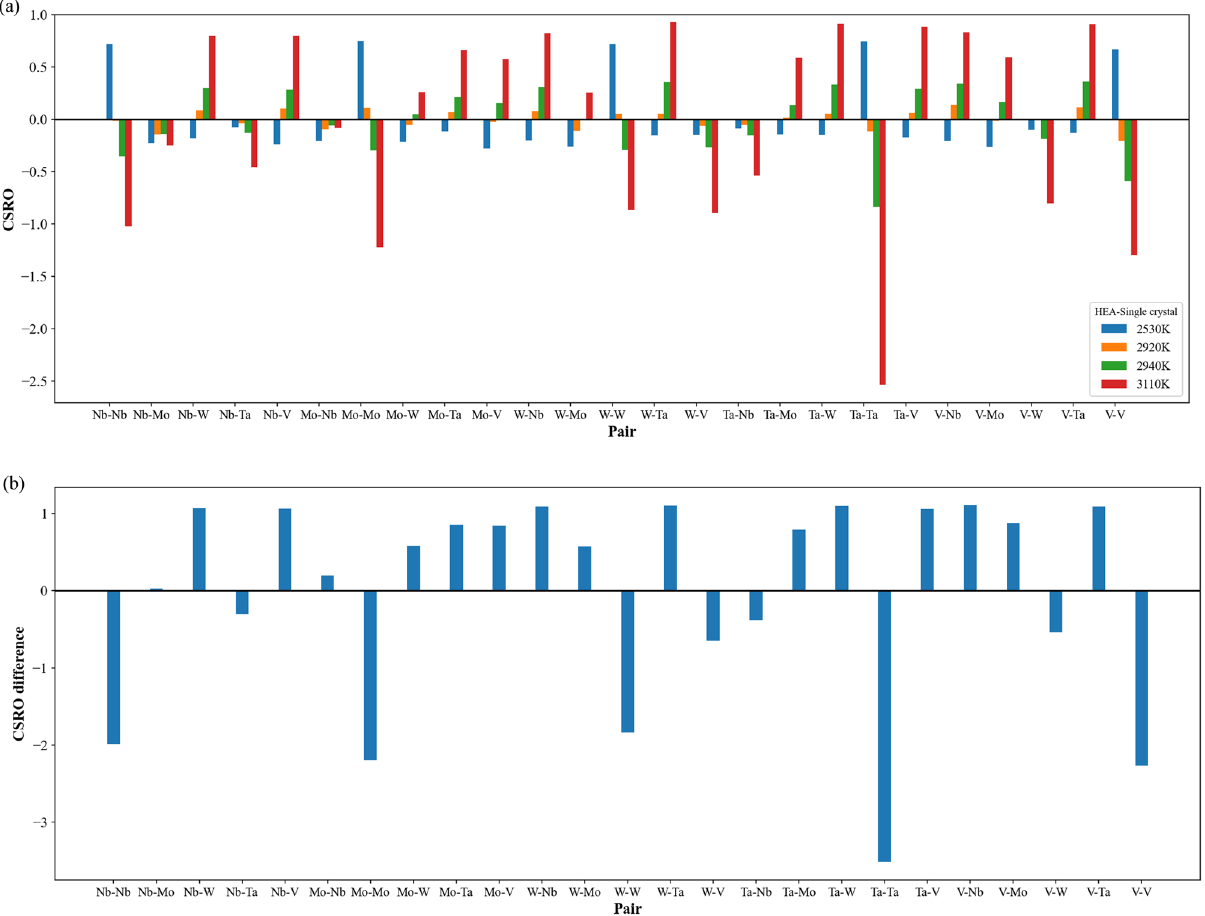
Figure 8. ( a ) The CSRO distributions for single crystal at four characteristic temperatures, 2530, 2920 (minimum of average CSRO square), 2940 (melting point), and 3110 K. ( b ) the differences of CSRO values of all pairs between 300 and 3110